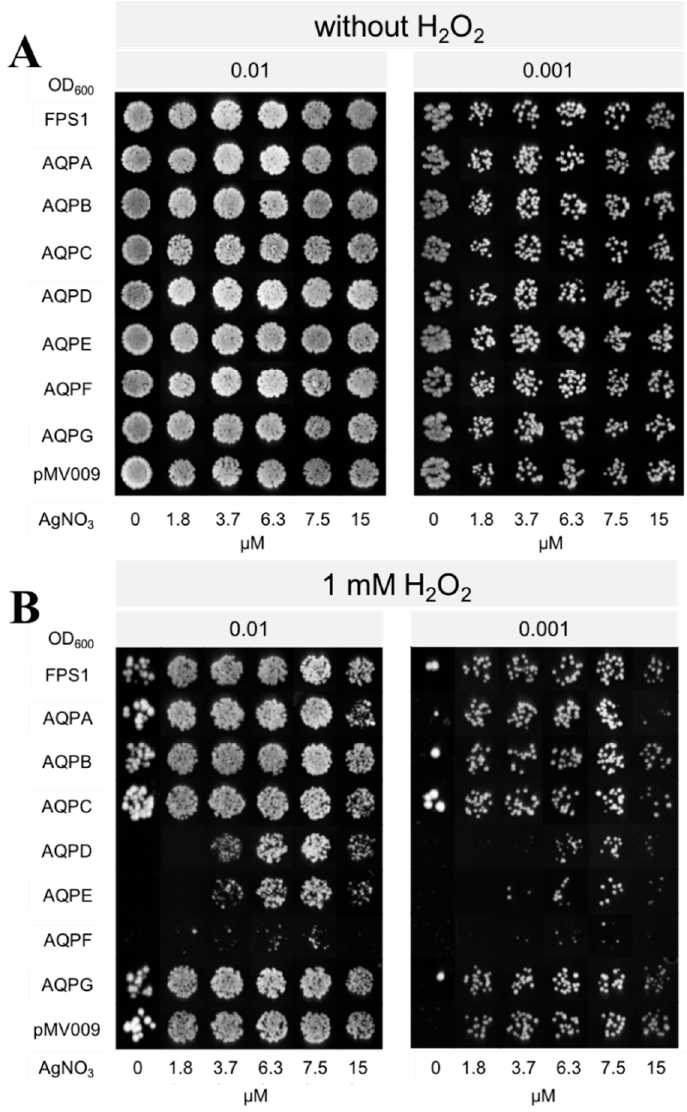
Figure 4. Phenotypic growth assay of S. cerevisiae strains expressing A. niger AQPs on AgNO 3 - containing agar media in the presence and absence of hydrogen peroxide. Overnight yeast cultures were diluted to an OD 600 of 0.1, and subsequently, serial dilutions were done from this one. The 5 µL of cell suspensions were spo tt ed on agar plates containing various AgNO 3 concentrations (0–15 µM). Growth phenotype was recorded after incubating for 6 days at 30 °C. The data shown are representative of three independent experiments with consistent results. ( A ) No hydrogen peroxide added. ( B ) In the presence of 1 mM hydrogen peroxide.